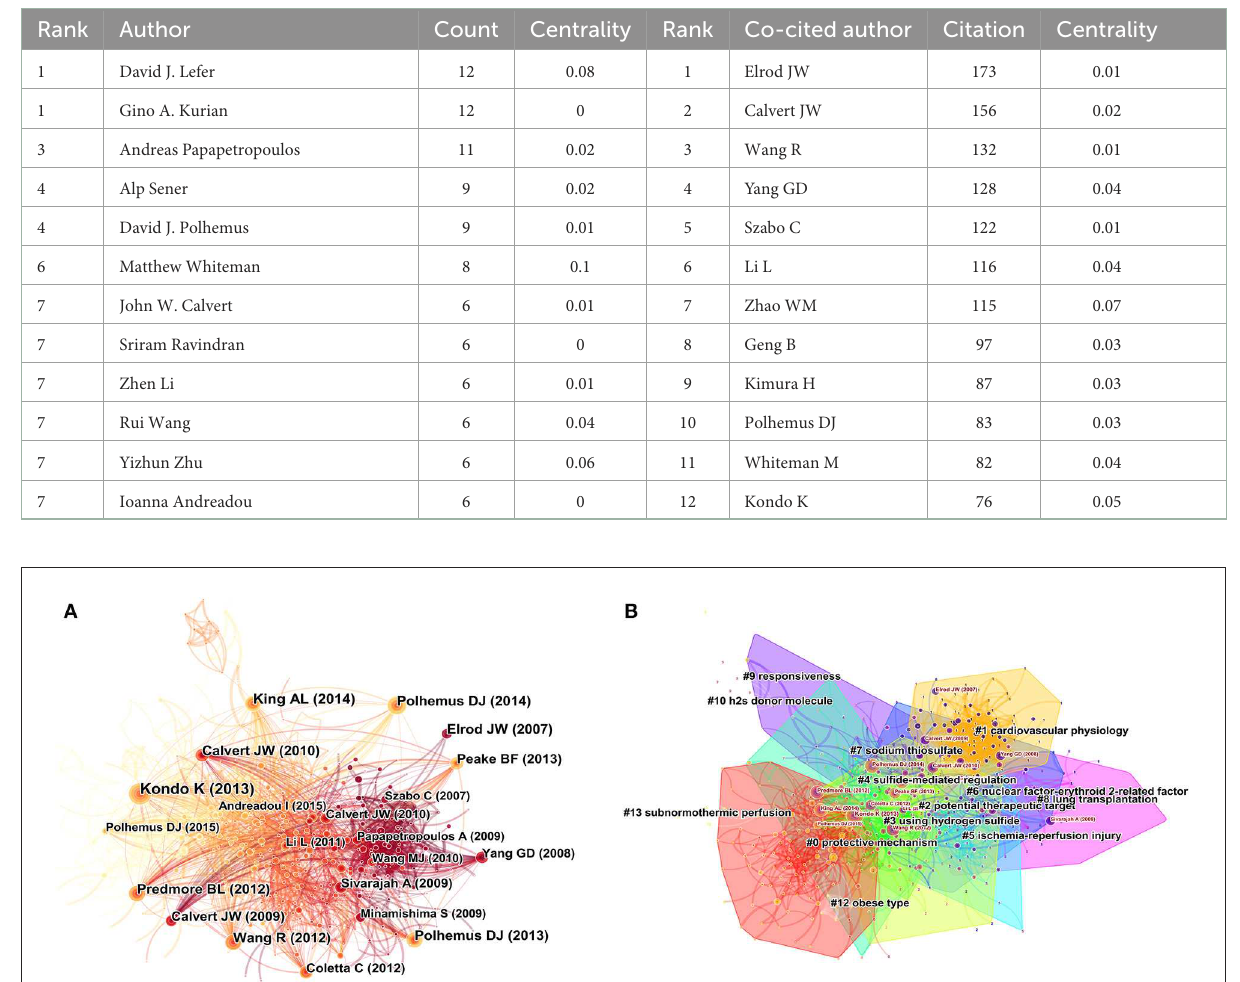
TABLE 3 Top 12 productive authors and co-cited authors in hydrogen sulfide in heart preservation research.